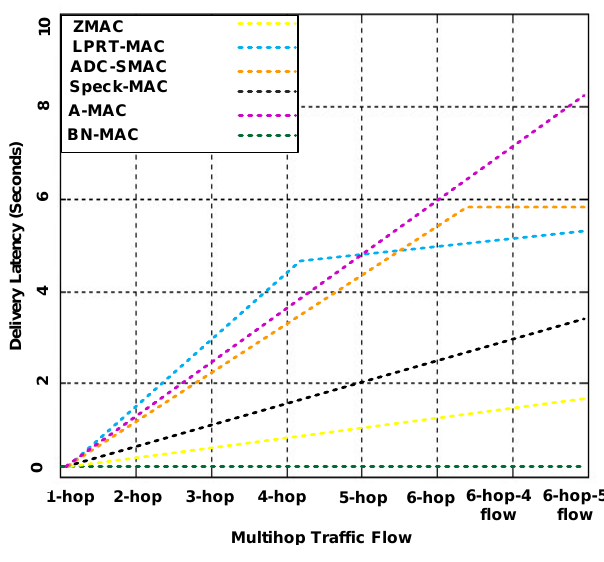
Figure 23. Latency of BN-MAC and the other hybrid protocols using different hops and traffic